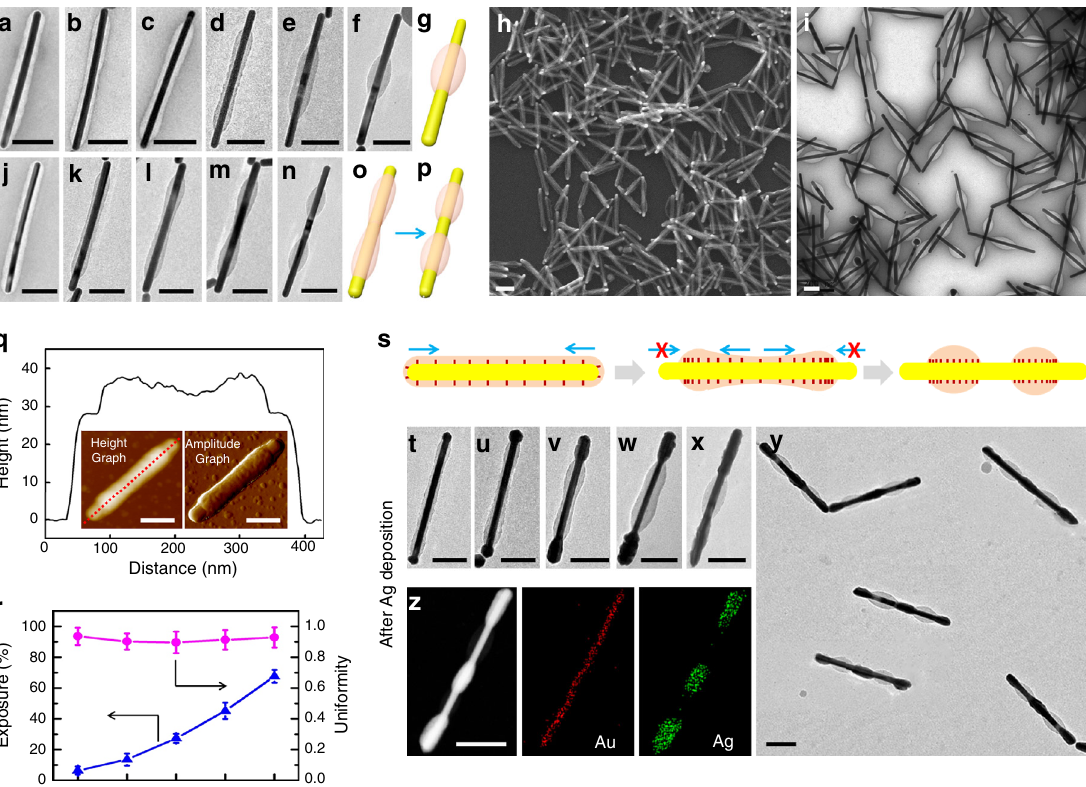
Fig. 2 Contraction and bimodal contraction modes. TEM images of a the initial core-shell (AuNR- 1 )@PSPAA; b – d the (AuNR- 1 )@PSPAA after 1.5 h b , 2.5 h c and 4 h d heating at 105 °C in water; e after 3 h heating in water at 110 °C; f and i after 3 h heating in water at 115 °C, with their structure illustrated by g . h SEM image of the sample c . j – n (AuNR- 2 )@PSPAA before j and after bimodal contraction at 90 °C for 3 h k , and the selected intermediates ( l , m ) towards the product at 6 h n . o , p Schematics illustrating the shell transformation from m to n . q AFM image and line scan of the (AuNR- 1 )@PSPAA in the sample h . r the average degree of exposure and the ratio of the two exposed ends (uniformity = l short / l long ) in the samples of b – f (based on at least 100 AuNRs). Error bars, s.d. ( n = 3). s Schematics illustrating the possible mechanism of bimodal contraction, where the crowded ligand restricts further contraction from the ends. t – y TEM images of the above masked nanosturctures after Ag depostion on the exposed Au surface, with t – x corresponding to b – f and y correponding to n . z STEM image and EDX mapping for Au and Ag on the (AuNR- 2 )@PSPAA after Ag deposition, respectively. The scale bars are 100